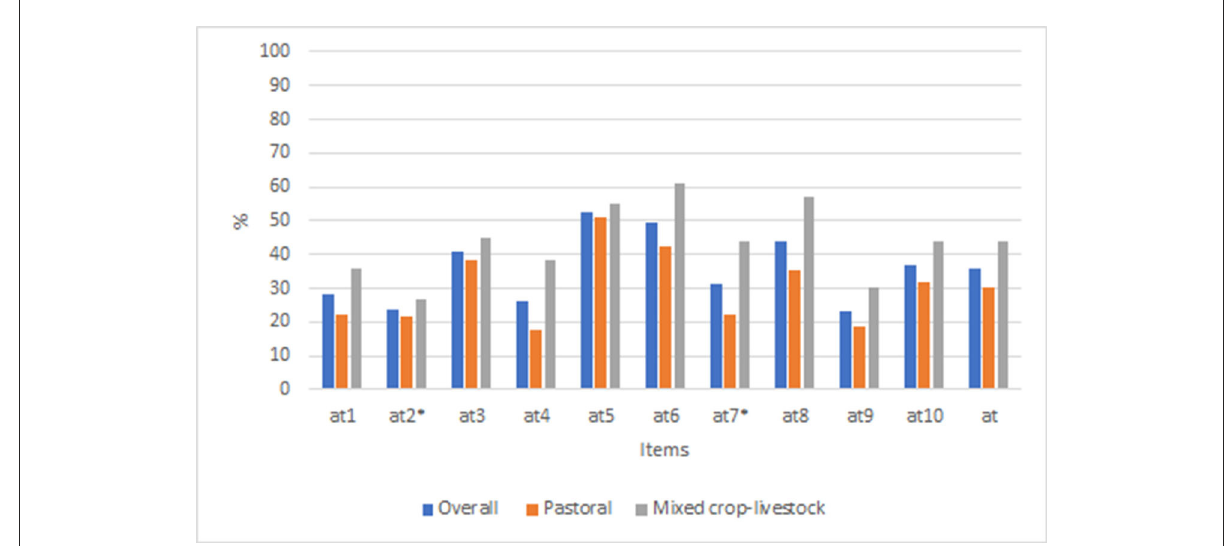
FIGURE6 Percent of correct responses for animal welfare attitude items aggregated by production system in Ethiopia. Items with “*” indicate the scale were reversed.